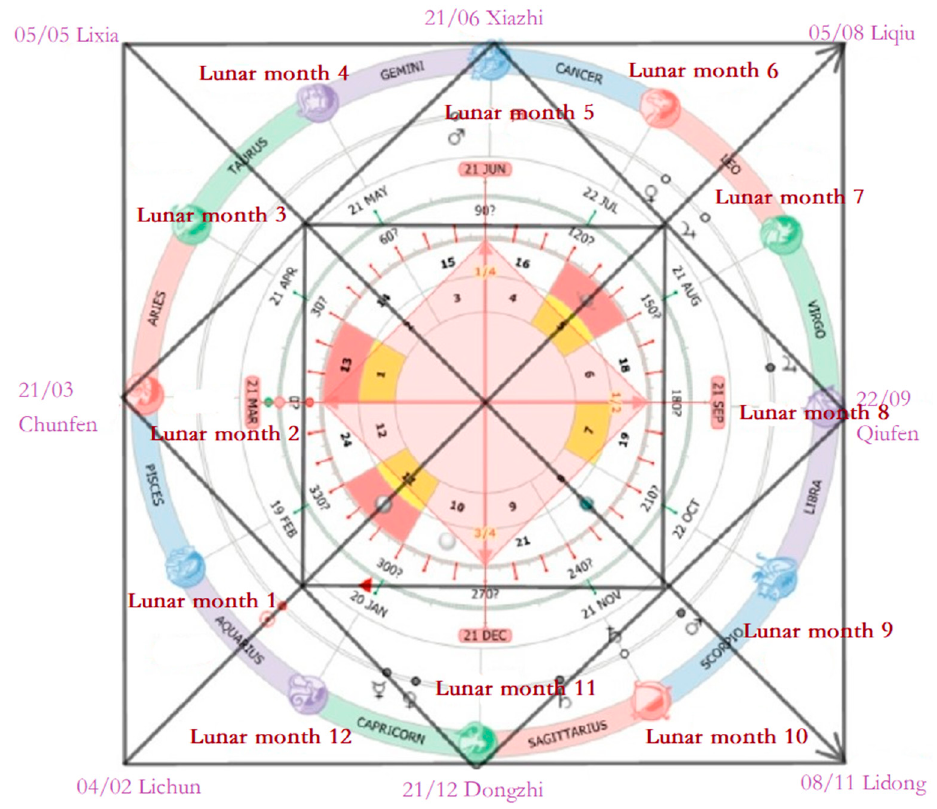
Figure 2. Twenty-four solar terms, 12 earthly branches in China corresponding to the Western cal- endar and constellation (From Sina Weibo, author: